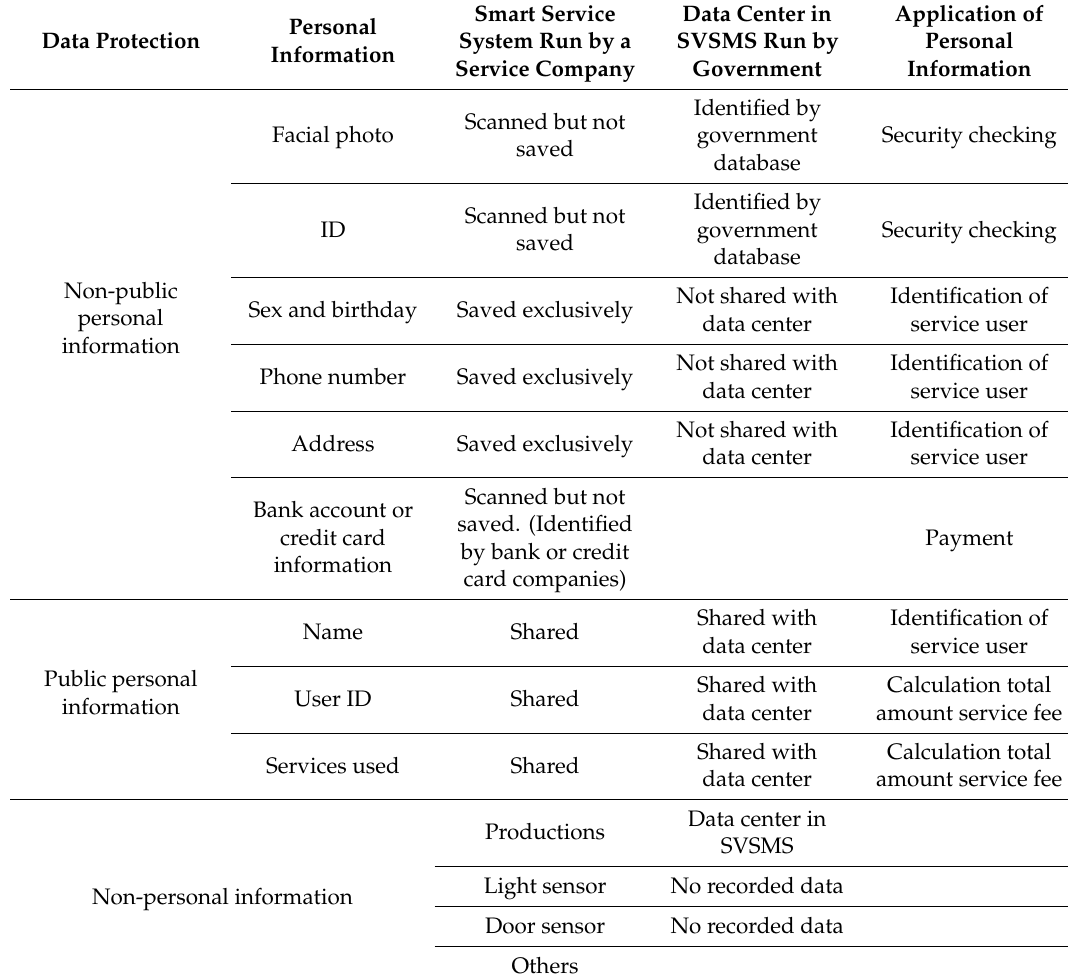
Table 4. Principles of personal information application for the smart visiting service